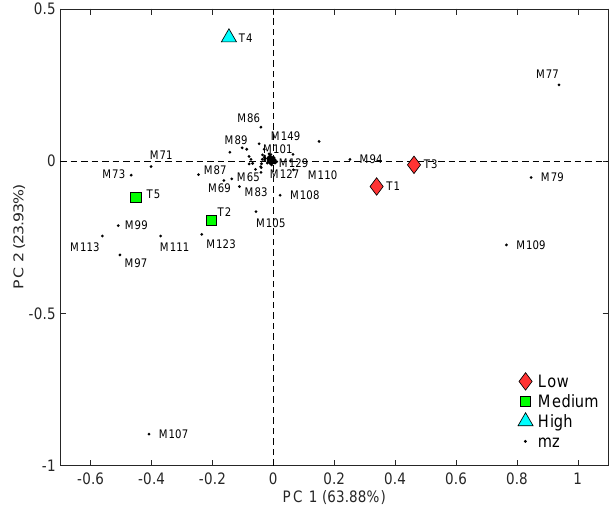
Figure 10. PCA loadings bi-plot of the second vs. first princi- pal components derived from the PCA analysis of the toluene experiments. Experiments were conducted under low NO x , high VOC / NO x ratio (red diamonds), moderate NO x , medium VOC / NO x ratio (green squares) and high NO x , low VOC / NO x ratio (blue triangle) conditions. For clarity, the scale has been set to show the bulk of the data; hence, m/z 93 and 85 are not